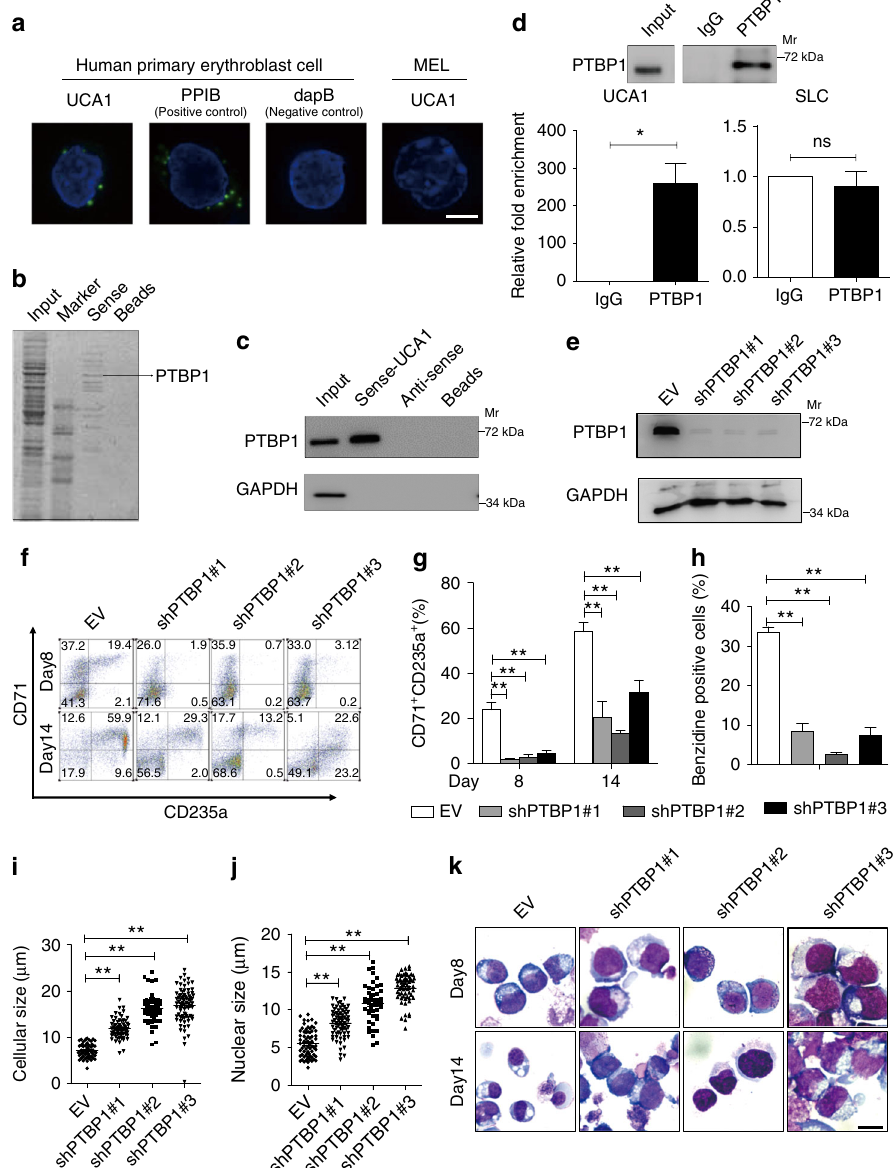
Fig. 3 UCA1 interacts with PTBP1 to regulate erythroid maturation. a UCA1 localization was determined by RNA-FISH in primary erythroid cells differentiated ex vivo for 8 days. Probes for PPIB act as a positive control and probes for bacterial gene dapB act as a negative control. MEL cells act as another negative control for the speci fi city of UCA1 probes. Scale bar = 5 μ m. b Mass spectrometry identi fi ed UCA1-interacting proteins after UCA1 RNA pull-down assay using in vitro transcribed RNA in AraC-induced K562 cells. c WB using anti-PTBP1 antibody, followed by UCA1 and antisense-UCA1 pull- down in HUDEP-2 cells. GAPDH was used as a negative control. d PTBP1 RIP assay in HUDEP-2 cells. WB con fi rmed PTBP1 immunoprecipitation (top). The relative fold enrichment of UCA1 in comparison with IgG was determined by qRT-PCR (bottom). SLC25A21-AS1 (hereafter we called it SLC for short) is an unrelated lncRNA and acts as a negative control. e PTBP1 expression examined by WB after shRNA-mediated PTBP1 knockdown with day 8 differentiated primary erythroid cells. GAPDH was used for internal control. f – k Human primary erythroid differentiation after PTBP1 depletion was assessed by fl ow cytometry (CD71 + CD235a + cells) ( f , g ), benzidine staining (percentage of positive cells) ( h ), the cellular and nuclear size ( i , j ) (on day 14, n = 50) and Wright-Giemsa staining ( k , Scale bar = 10 μ m) after 8 and 14 days induction. Bar graphs were generated with data from three independent experiments ( n = 3). Error bars represent SEM. P -values were determined by Student ’ s t -test. *P < 0.05, **P <